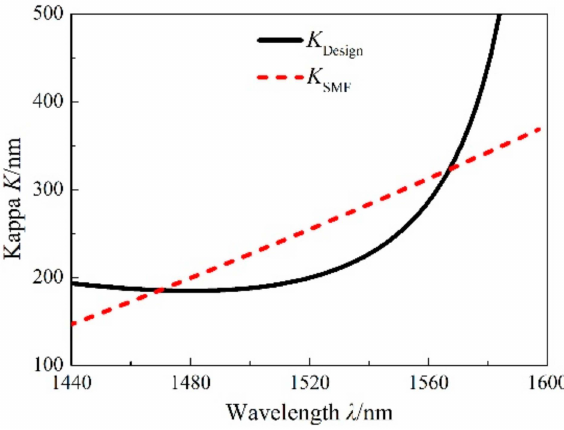
Figure 3. Variation of K value with wavelength.